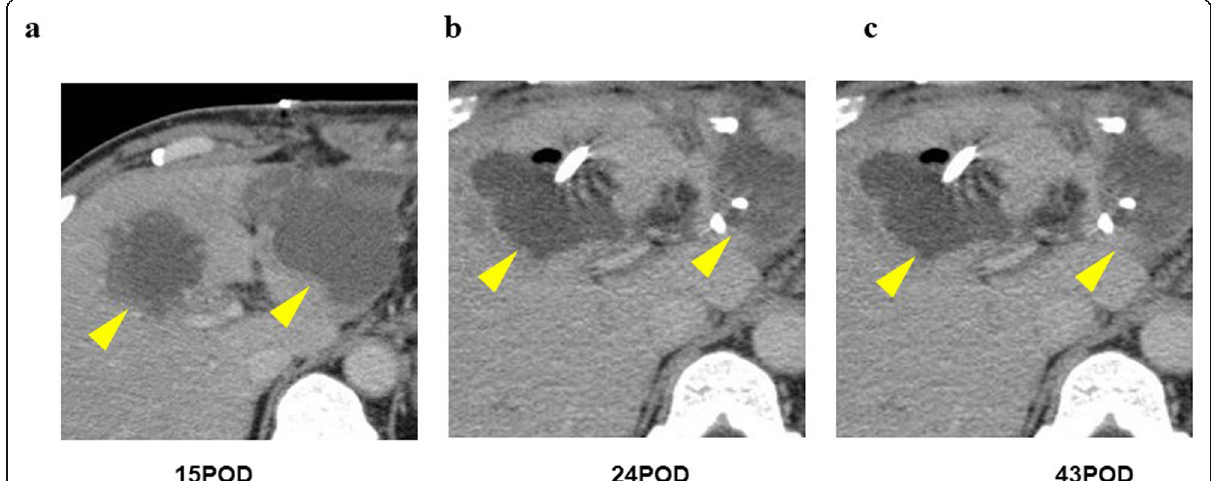
Fig. 2 Several time drainage for multiple liver abscesses after operation